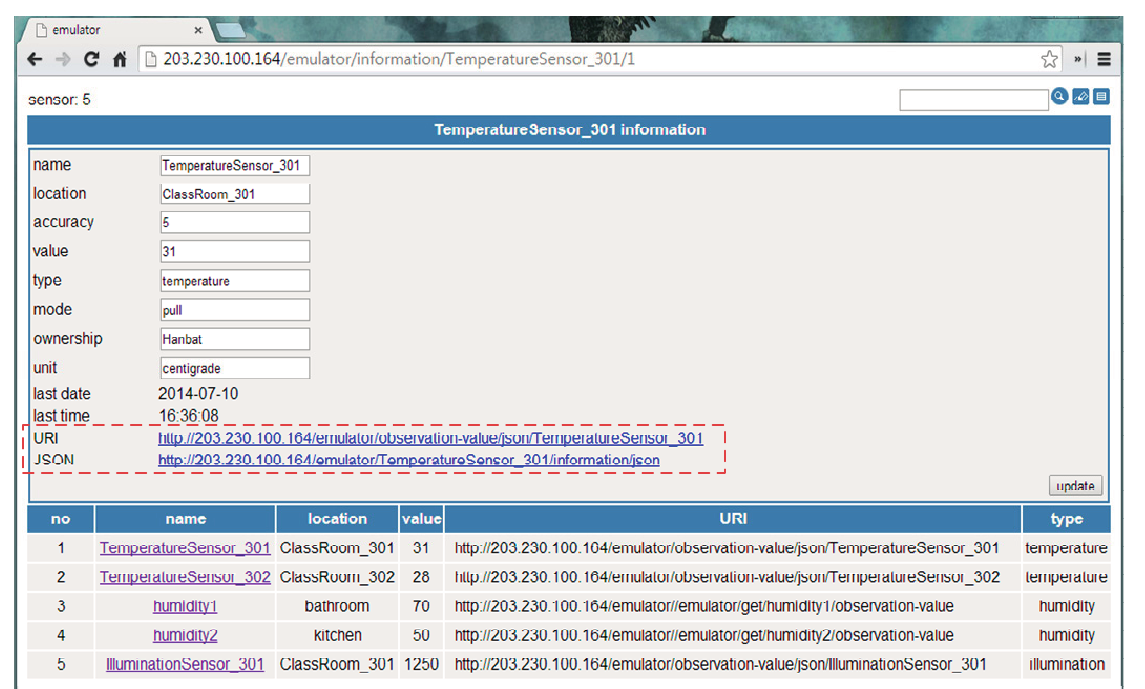
Figure 6. Monitoring UI of the RESTful smart space gateway.